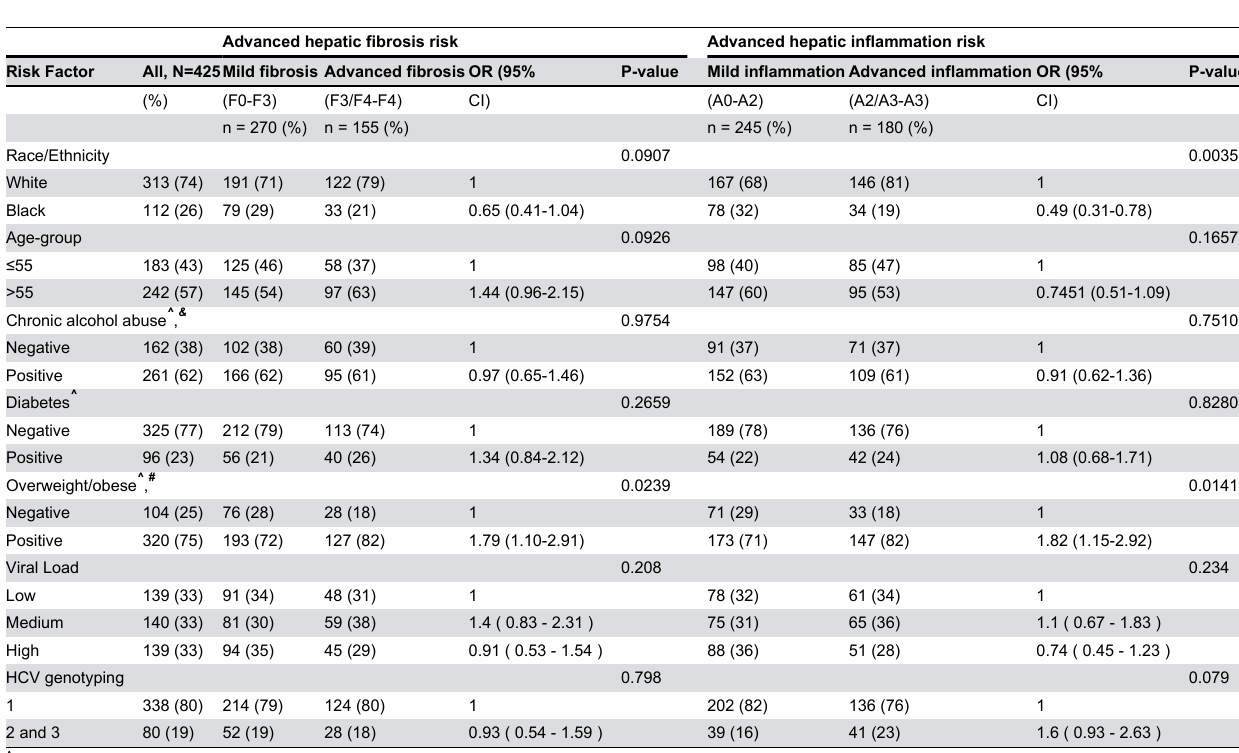
Table 1. Sociodemographic and clinical characteristics of male veterans with chronic hepatic C virus (HCV) infection based on FibroSURE-determined hepatic fibrosis and